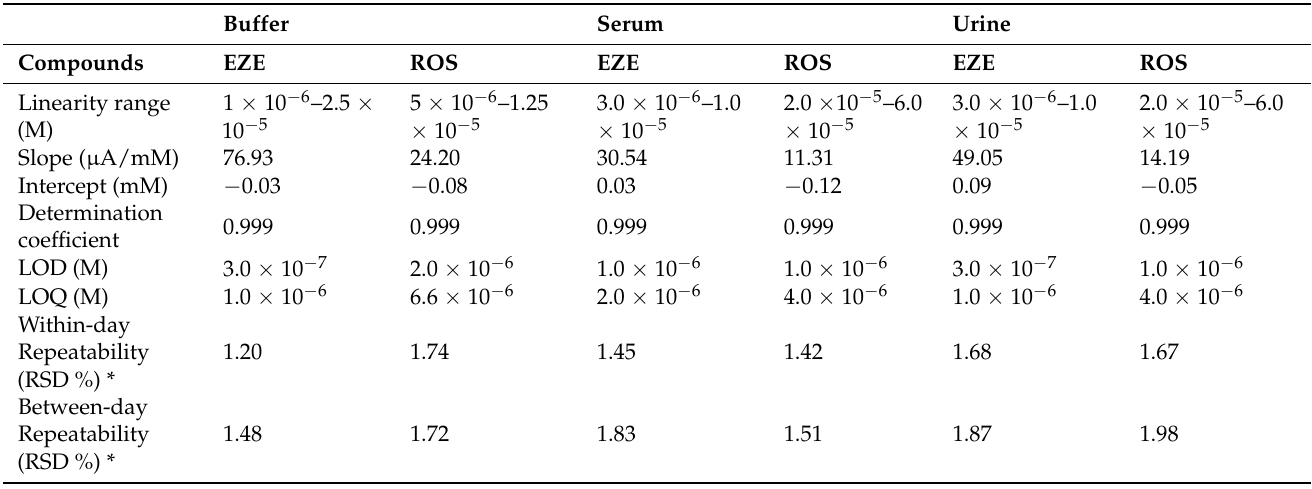
Table 1. Statistical assessment of the calibration data for determination of ROS and EZE by the AdS- DPV method in 0.1 M H 2 SO 4 (stripping conditions: accumulation potential of 0.0 V and accumulation time of 15 s).